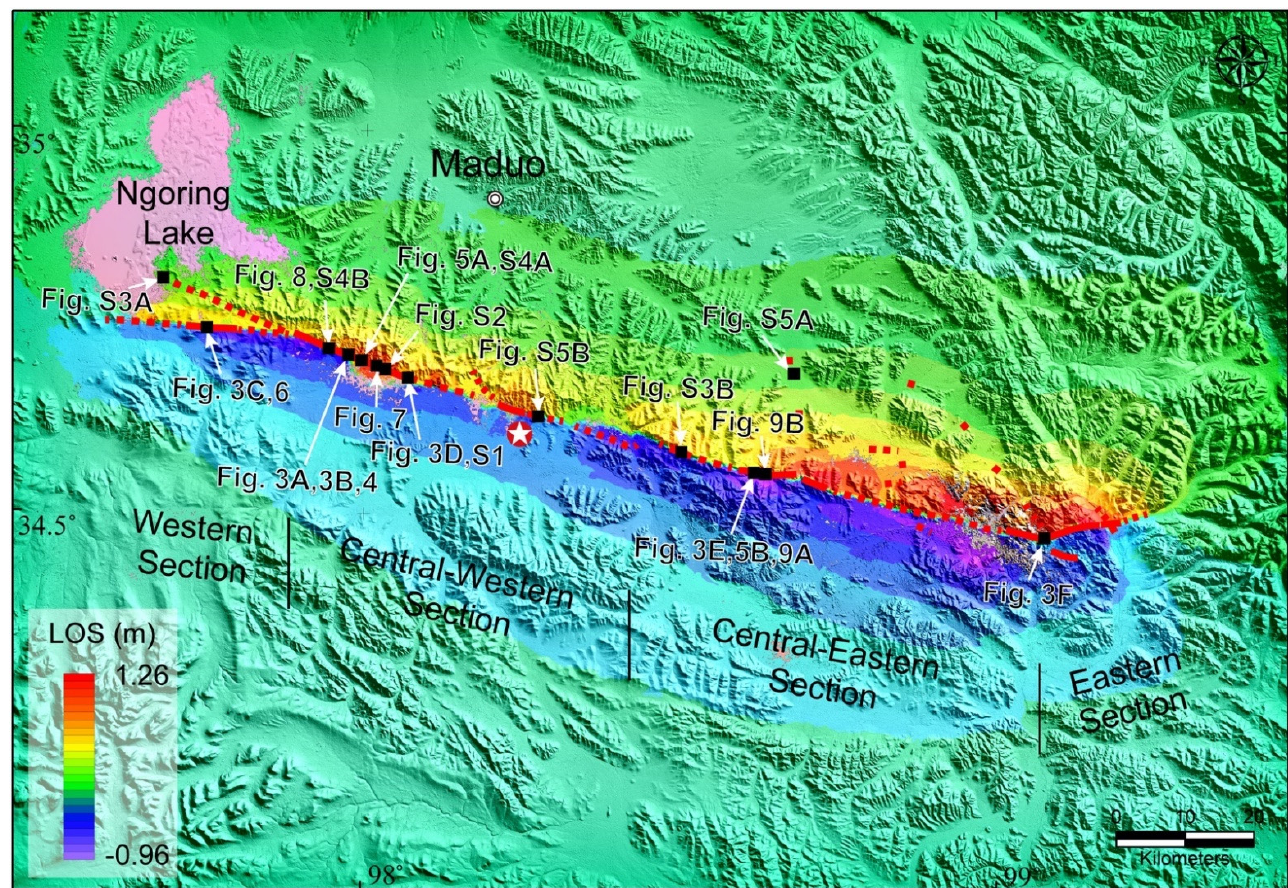
Figure 2. A map of D-InSAR LOS coseismic deformation and sites investigated during the field survey with the locations of the corresponding figures of the paper. The dotted red lines indicate discontinuous rupturing of fault traces, and the solid red lines indicate continuous surface rupture. The color shading represents the amount of LOS coseismic deformation, and its values were obtained by analyzing D-InSAR data collected from the ascending orbit of the Sentinel-1 satellite.